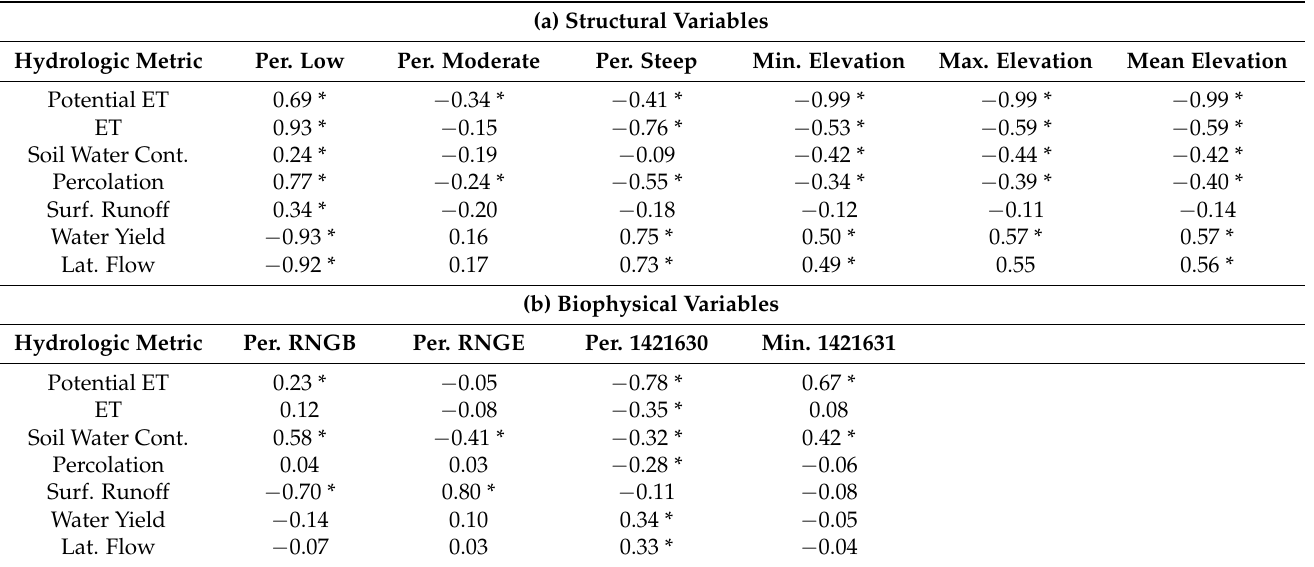
Table 3. Showing correlations between the modeled hydrologic metrics derived using the Soil & Water Assessment Tool (SWAT) and variables that are representative of the ( a ) structural and ( b ) biophysical layers used as inputs in SWAT. Significant correlations ( p -value < 0.05) are identified with